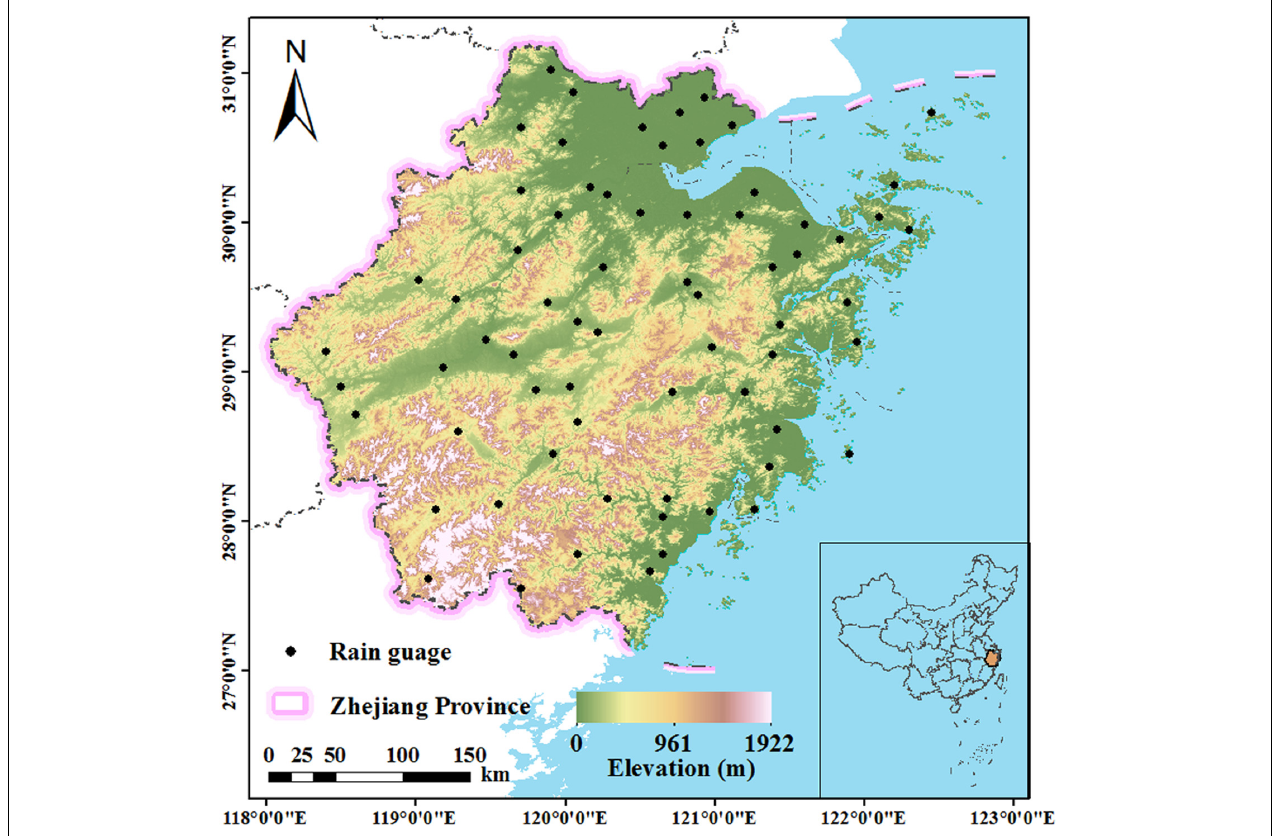
FIGURE 1 | Spatial distribution of 68 ground observation stations and DEM over Zhejiang, Southeastern